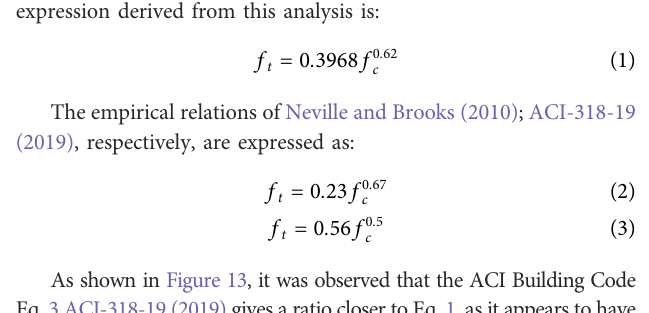
insulator according to RILEM-LC2 (1978) (kc sample < .75 W/mK,; f ′